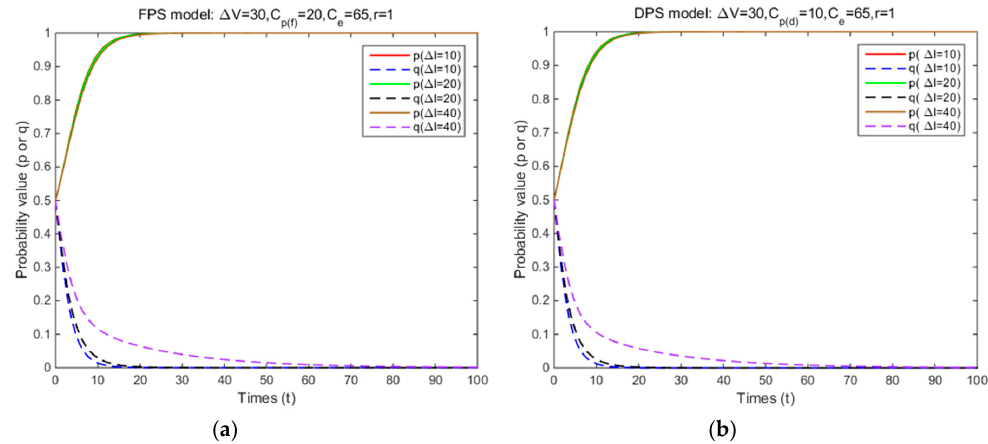
Figure A7. The effects of relative public image cost on strategy probabilities of cyclists and law enforcement under FPS ( a ) and DPS ( b ) (Situation 1).